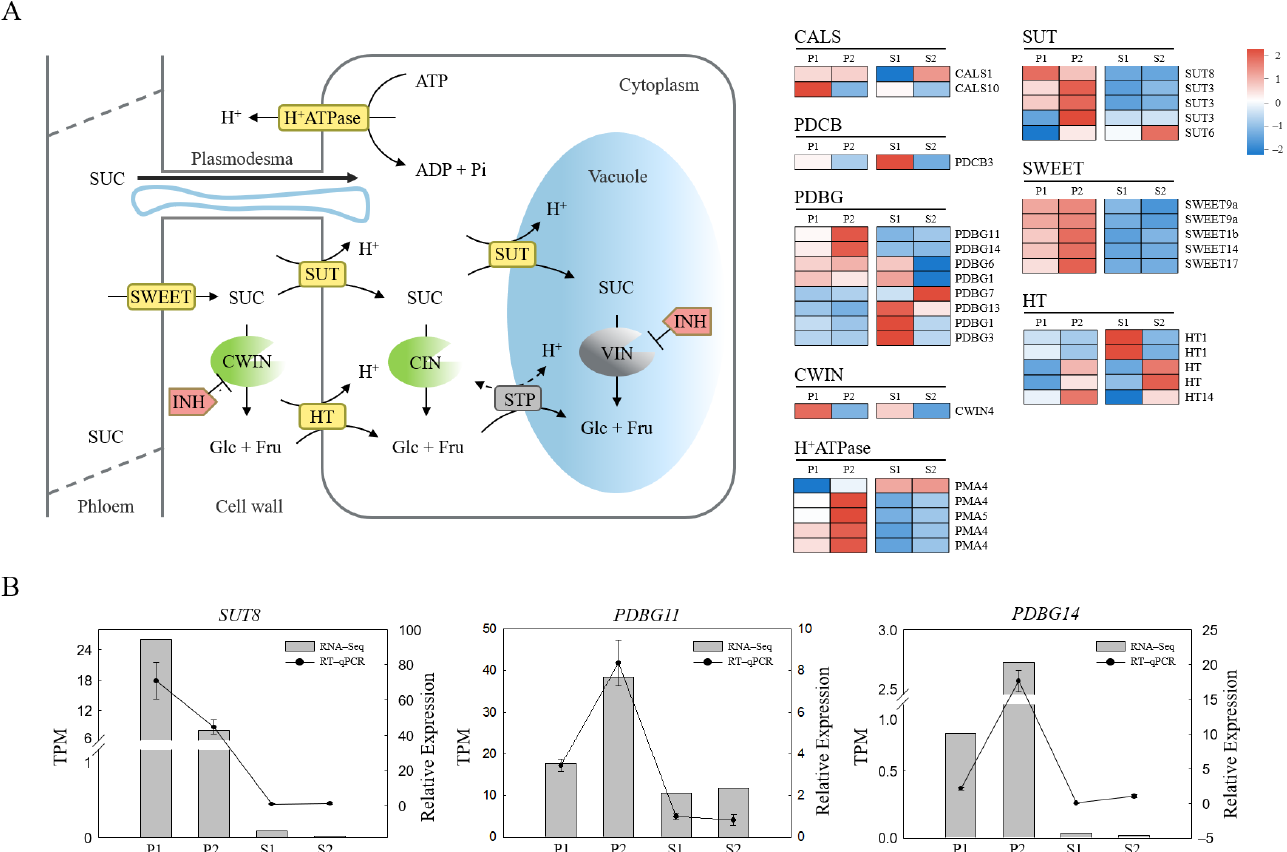
Figure 3. Expression of the differently expressed genes involved in phloem unloading of C. oleifera. ( A ) The current known model for principal transport steps and pathways for phloem unloading in C. oleifera . The heatmap of gene expression was generated from hierarchical cluster analysis of genes. Heatmap colors indicate the standardized expression level in each sample, and red and blue indicate from high and low expression, respectively, as shown in color bar on the right; ( B ) Gene expression patterns observed by RNA-seq (Y-axis on the left) and qPCR (Y-axis on the right). Error bars indicate SE ( n = 3). P1: pericarp in August; P2: pericarp in September; S1: seeds in August; S2: seeds in September.